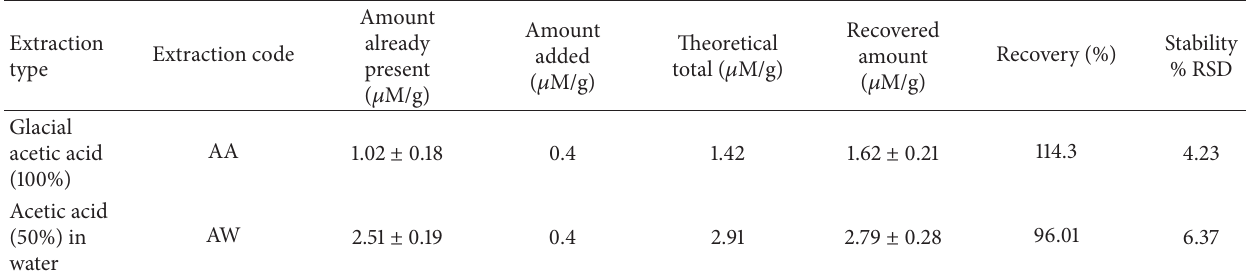
Table 2: Recovery ( 𝑛 = 9 ) and stability ( 𝑛 = 9 ) studies of the spectrophotometric method.